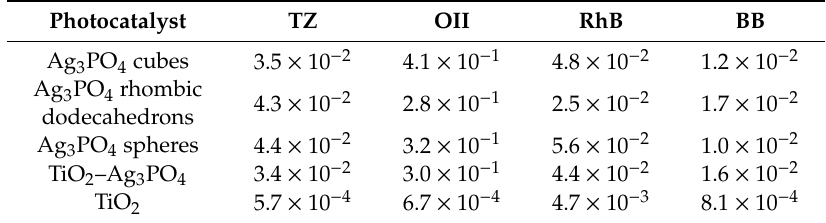
Figure 5. Relative concentration of TZ ( a ), OII ( b ), RhB ( c ) and BB ( d ) vs. time in the presence of Ag 3 PO 4 cubes ( ● ), Ag 3 PO 4 rhombic dodecahedrons ( ▲ ), Ag 3 PO 4 spheres ( ▼ ), hybrid Ag 3 PO 4 –TiO 2 ( ♦ ), or TiO 2 ( ■ ), under 450 nm irradiation. Initial concentrations: 5 × 10 − 5 M (dye) and 0.5 g/L (photocatalyst) in aerated aqueous media. Table 3. Pseudo-first order constants (min − 1 ) determined for the photodegradations performed under 450 nm irradiation.